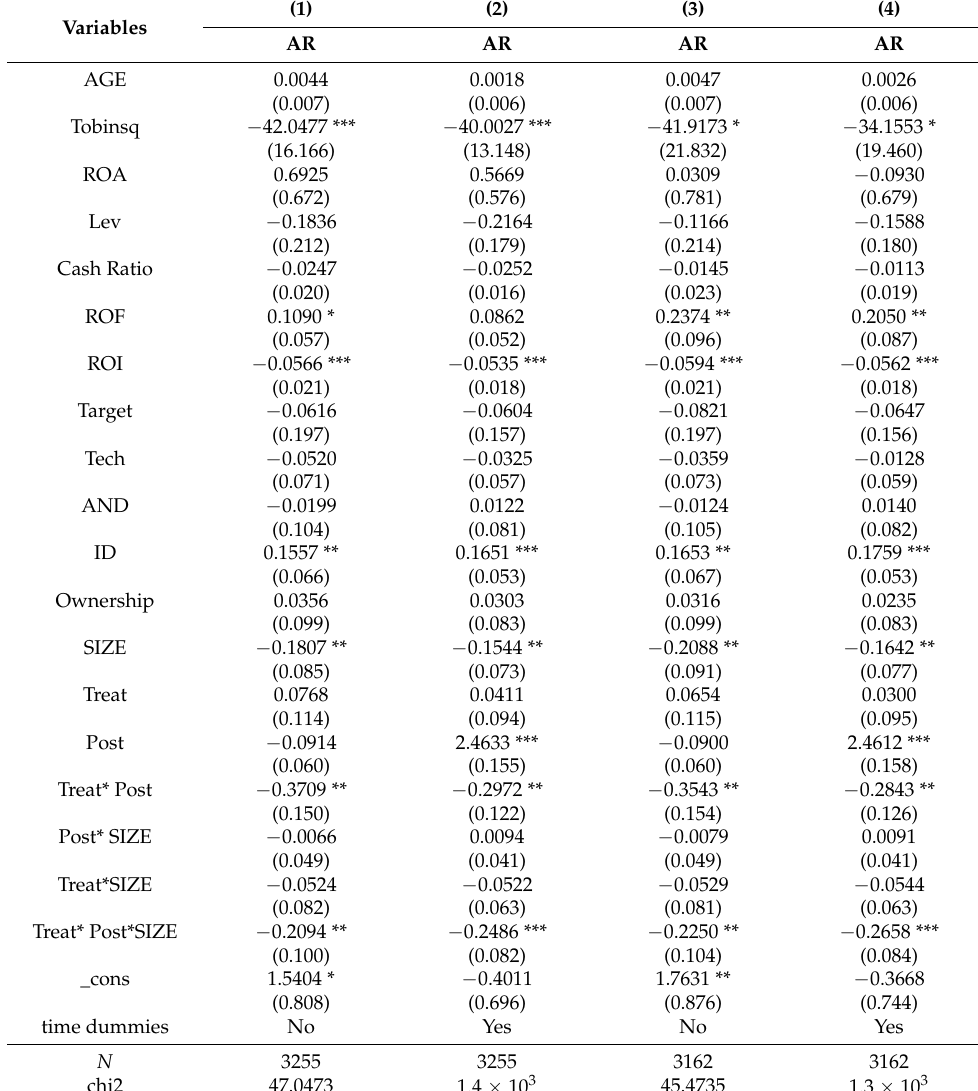
Table 11. Regression results of the moderating effect of firm